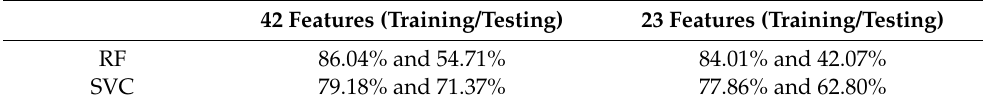
Table 9. Multiclass classification accuracy when multiple features were